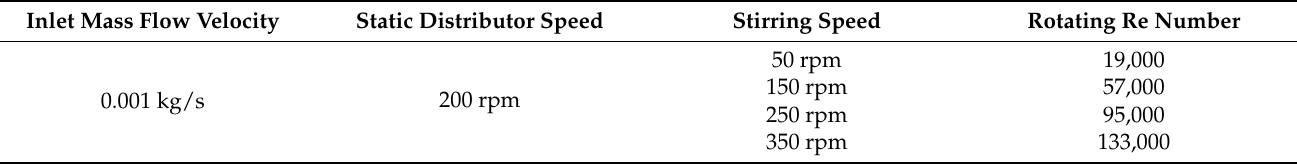
Table 3. Parameter